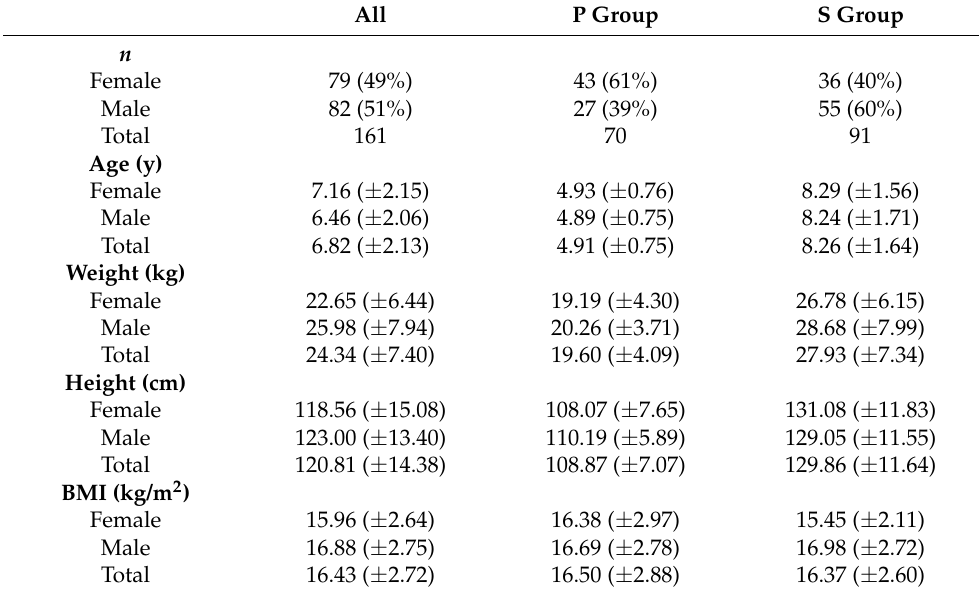
Table 1. Characteristics of the group. Whole group characteristics as well as in division of sex. The data are described as means and standard deviations. All P Group S Group